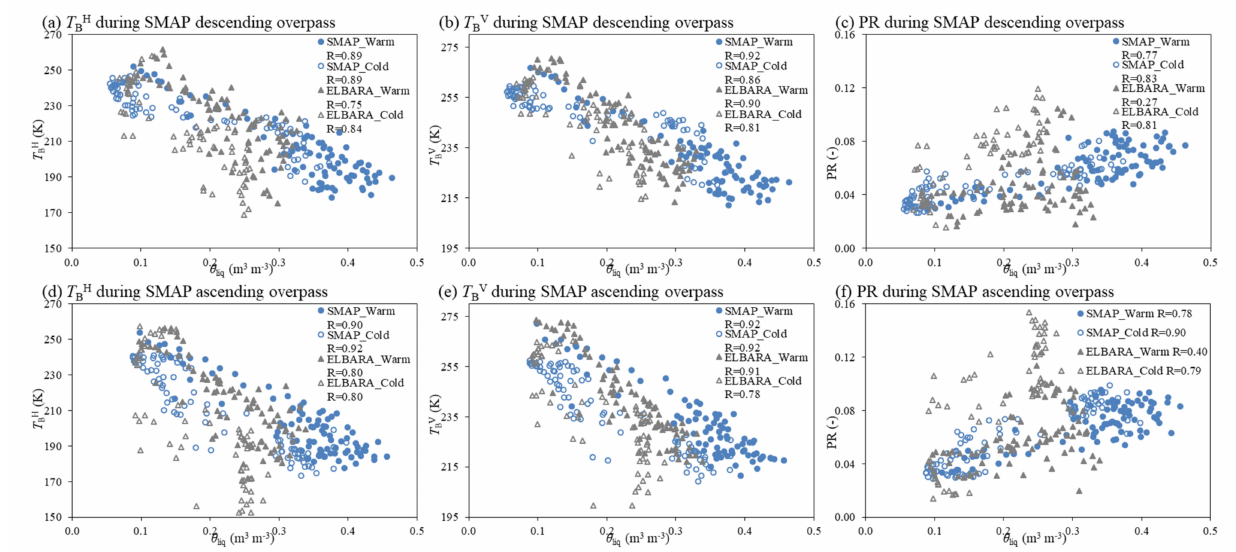
Figure 5. Scatter plots of the T BH ( a , d ), T BV ( b , e ) and polarization ratio (PR) ( c , f ) obtained from both SMAP and ELBRA-III measurements versus θ liq at a depth of 5 cm taken from in situ data collected within the SMAP and ELBRA footprints for the SMAP descending ( a – c ) and ascending ( d – f ) overpasses in the cold (November–April) and warm (May–October) seasons. The corresponding correlations (R) are also